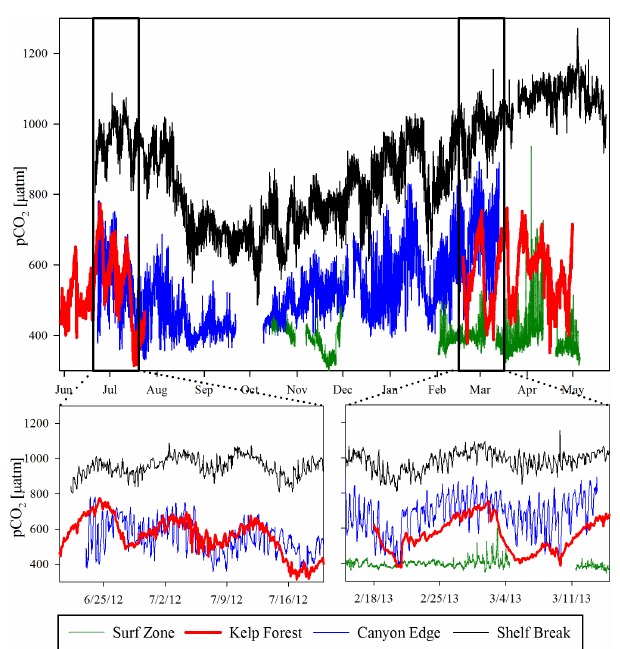
Figure 7. Time series of (cid:127) Ar calculated from sensor pH and TA est between June 2012 and June 2013. The two lower panels are month- long snapshots. (cid:127) Ar is reported at in situ